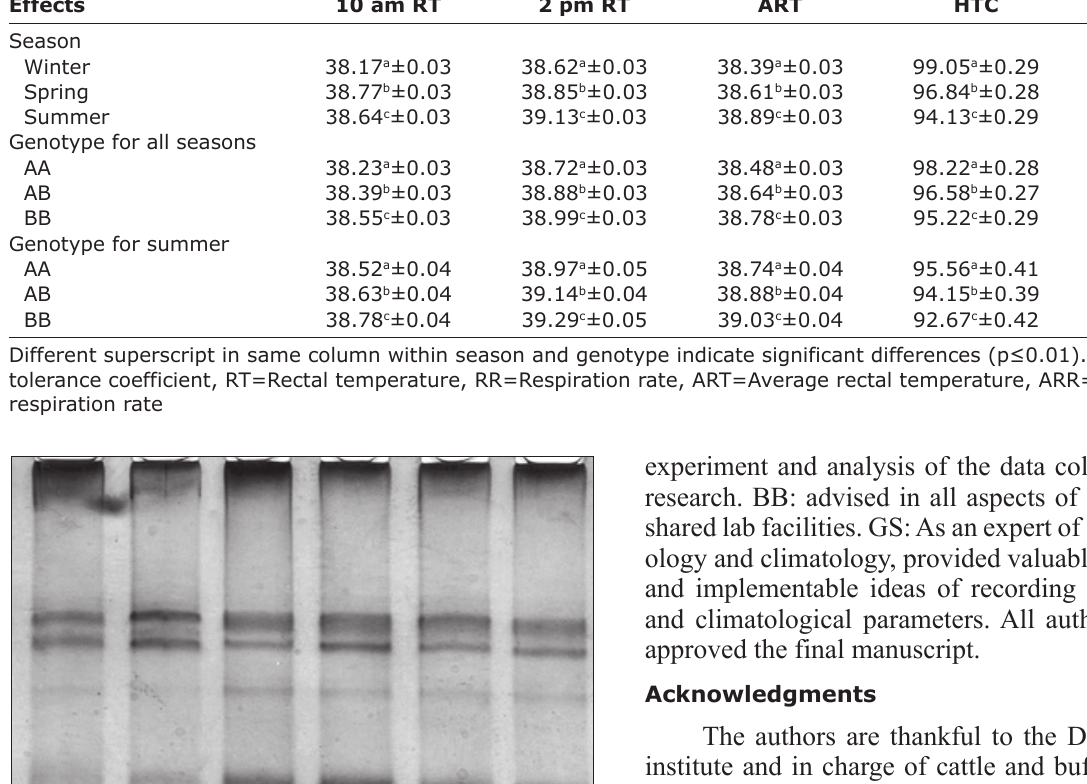
Table-2: Effects of genotype and season on heat tolerance parameters on Tharparkar cattle.